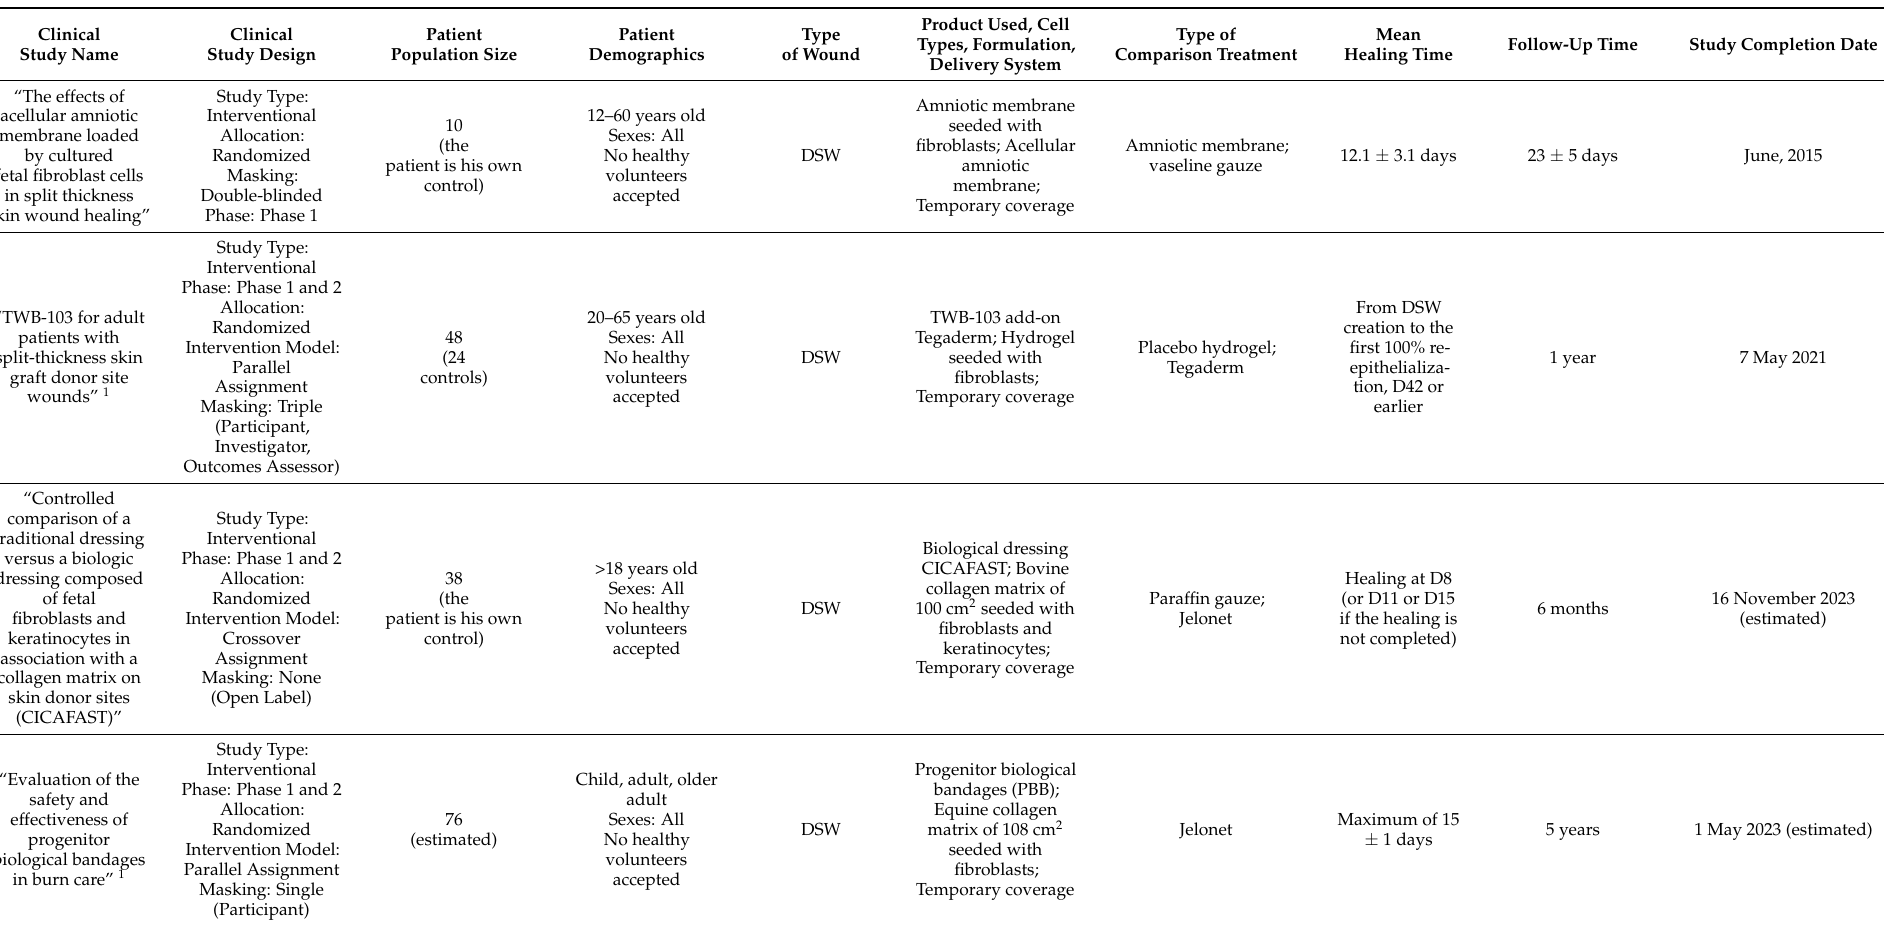
Table 1. Summary of registered randomized clinical trials around the world (i.e., completed or ongoing trials) on the homologous therapeutic use of allogeneic progenitor cells from cutaneous origin. The primary and secondary outcomes of the listed clinical trials are further summarized in Table S1. DSW, donor site wound; PBB, progenitor biological